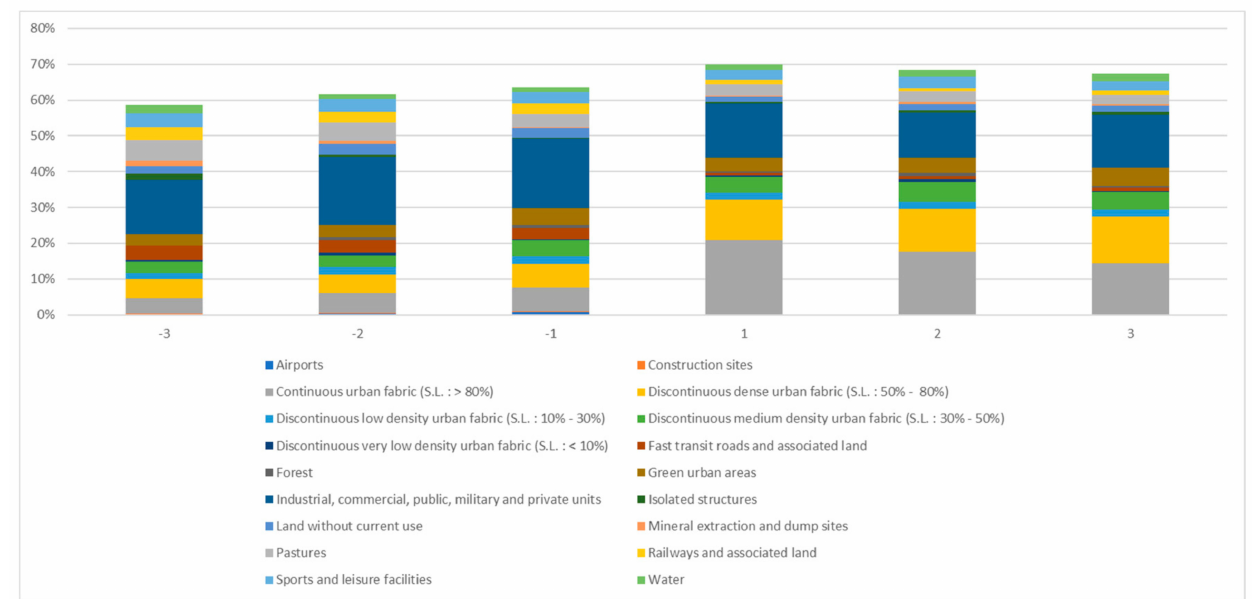
Figure 20. Ratio comparison of the land use dataset excluding arable land (annual crops) and other roads and associated land contained by hot/cold spots detected.